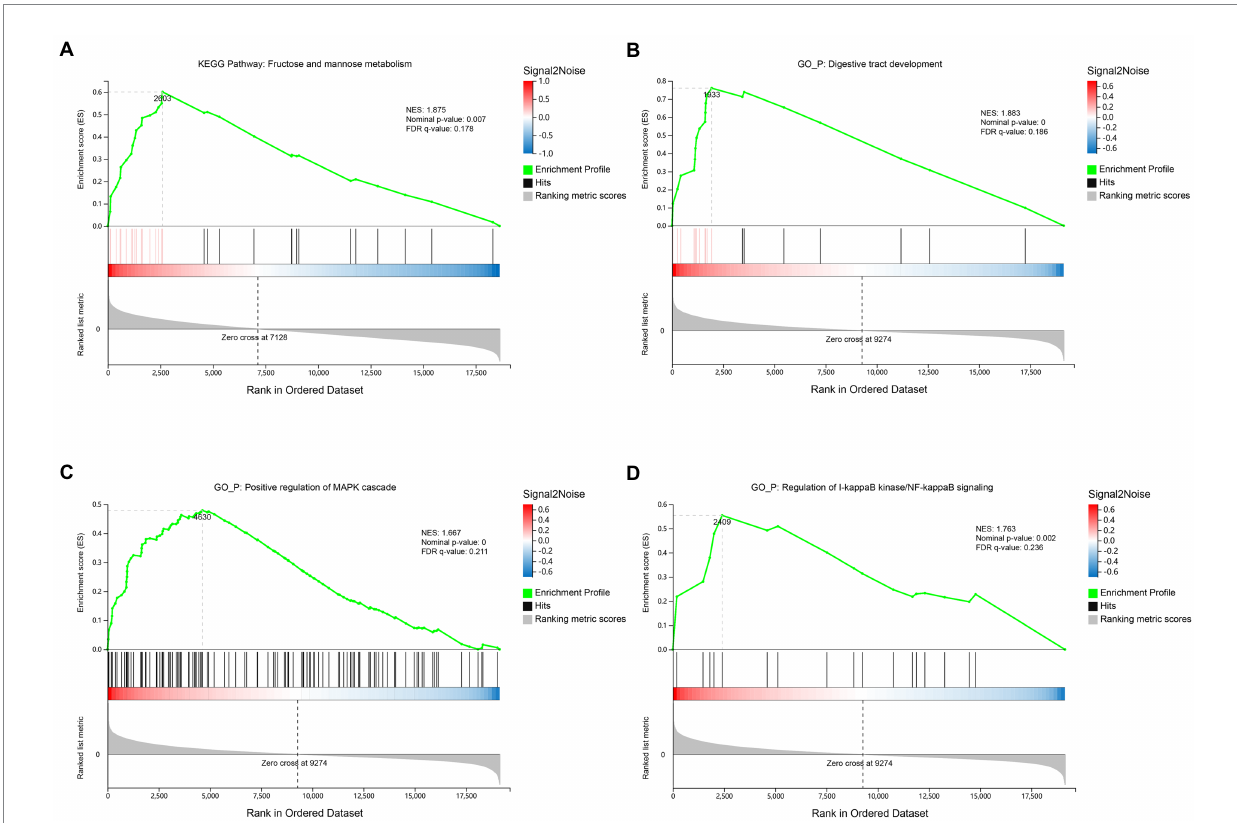
FIGURE 1 Transcriptome gene set enrichment analysis (GSEA) of rumen and ileum tissue of lambs in the CON and SIL groups. (A) : Gene set enriched in Fructose and mannose metabolism pathway of rumen; (B) : Gene set enriched in digestive tract development biological process of ileum; (C) : Gene set enriched in positive regulation of MAPK cascade biological process of ileum; (D) : Gene set enriched in regulation of I-kappaB kinase/NF-kappaB signaling biological process of ileum. Screening criteria for significant gene sets included adj. p -value <0.05 and FDR < 0.25. NES: normalized enrichment